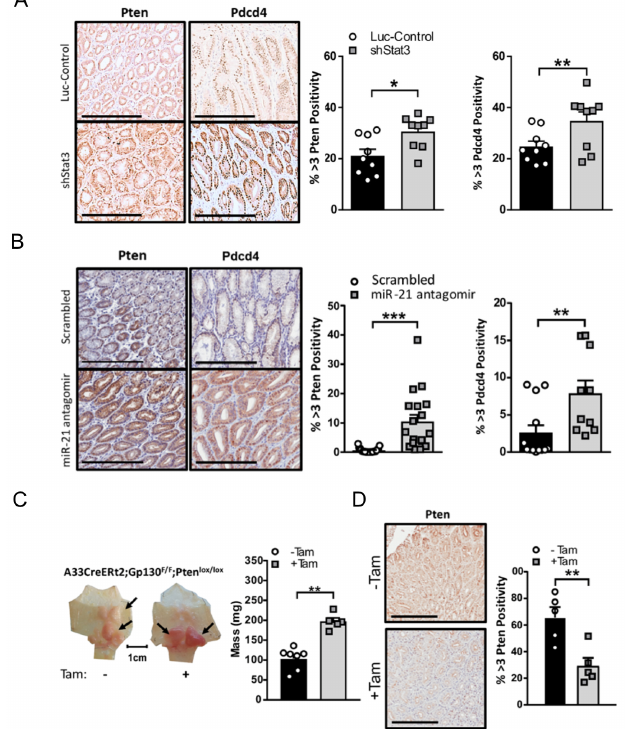
Figure 5. miR-21-dependent suppression of Pten and Pdcd4 contributes to gastric adenoma formation in mice. ( A ) Representative images of Pten and Pdcd4 IHC stains on cross-sections of adenomas from 18-week old Gp130 F/F ; shStat3 ; rtTA and Gp130 F/F ; shLuc ; rtTA mice 2 weeks after DOX treatment. The quantification of the staining was performed by ImageScope analysis software. ( B ) Representative images of Pten and Pdcd4 IHC stains on cross-sections of adenomas collected from 12-week old Gp130 F/F mice after the end of a 4-week treatment period with the scrambled control or miR-21 antagomir. The quantification of the staining was performed by ImageScope analysis software. ( C ) Representative whole mounts of stomachs excised from 12-week old gpA33: CreERT2; Gp130 F/F ; Pten fl/fl mice 2 weeks after tamoxifen administration to ablate Pten in the the metaplastic epithelium of the tumors. Each symbol represents the total tumor weight of an individual mouse. ( D ) Representative images of Pten and Pdcd4 IHC stains in adenomas of mice from ( C ). The quantification of the staining was performed by ImageScope analysis software. The data are presented as the mean ± SEM, with each point representing an individual mouse. * p < 0.05; ** p < 0.01; *** p < 0.001. Scale bar = 200 µ